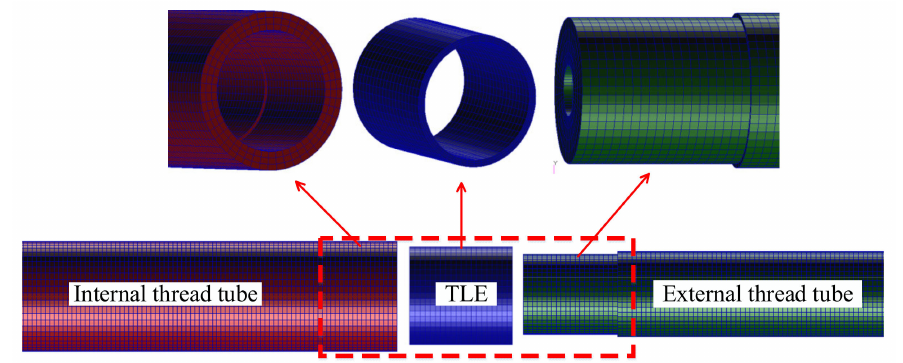
Figure 7. FE models of the threaded tubes and TLE (source elaborated by